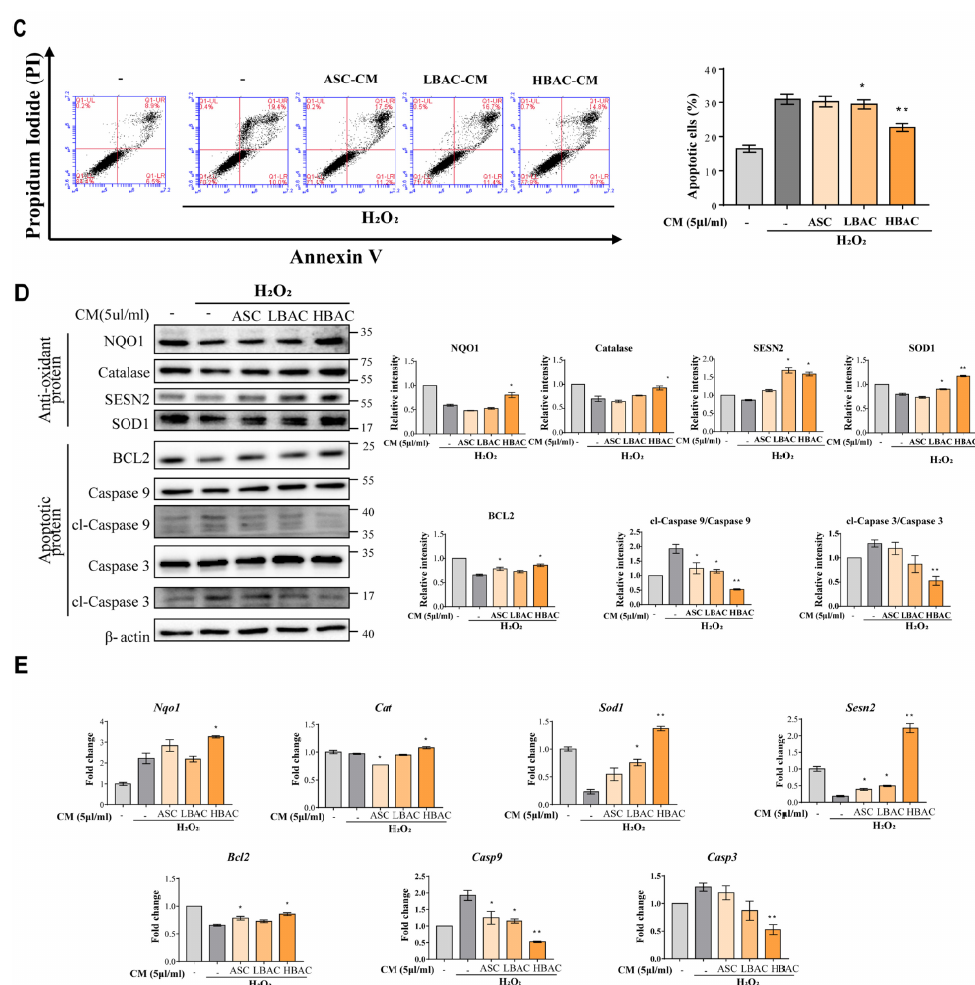
Figure 3. Regulation of antioxidant and apoptotic factors by beige adipocyte secretions. ( A ) Cell viability and cytotoxicity in H9c2 cells under H 2 O 2 stimulation. ( B ) Cell viability and cytotoxicity in H9c2 cells under H 2 O 2 stimulation with CM. H9c2 cells were treated with 300 µ M H 2 O 2 for 3 h and then exposed to CM for 1 h. The data are shown as the mean ± standard error of the mean ( n = 5). ( C ) Annexin V/PI staining as detected by flow cytometry. ( D , E ) Differential expression of antioxidant/apoptotic factors in H9c2 cells by ASC, LBAC, or HBAC-derived CM treatment. The factors were determined using western blot analysis ( D ) and qPCR ( E ). The data are shown as the mean ± standard error of the mean ( n = 3). * p < 0.05 and ** p < 0.01 vs. non-treated ( A ) or H 2 O 2 -treated group ( B – E ). cl means ”cleaved